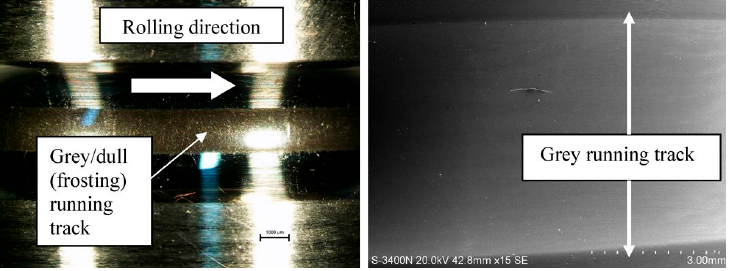
Figure 4. Frosting on the inner raceway ring and a magnified view of the running track